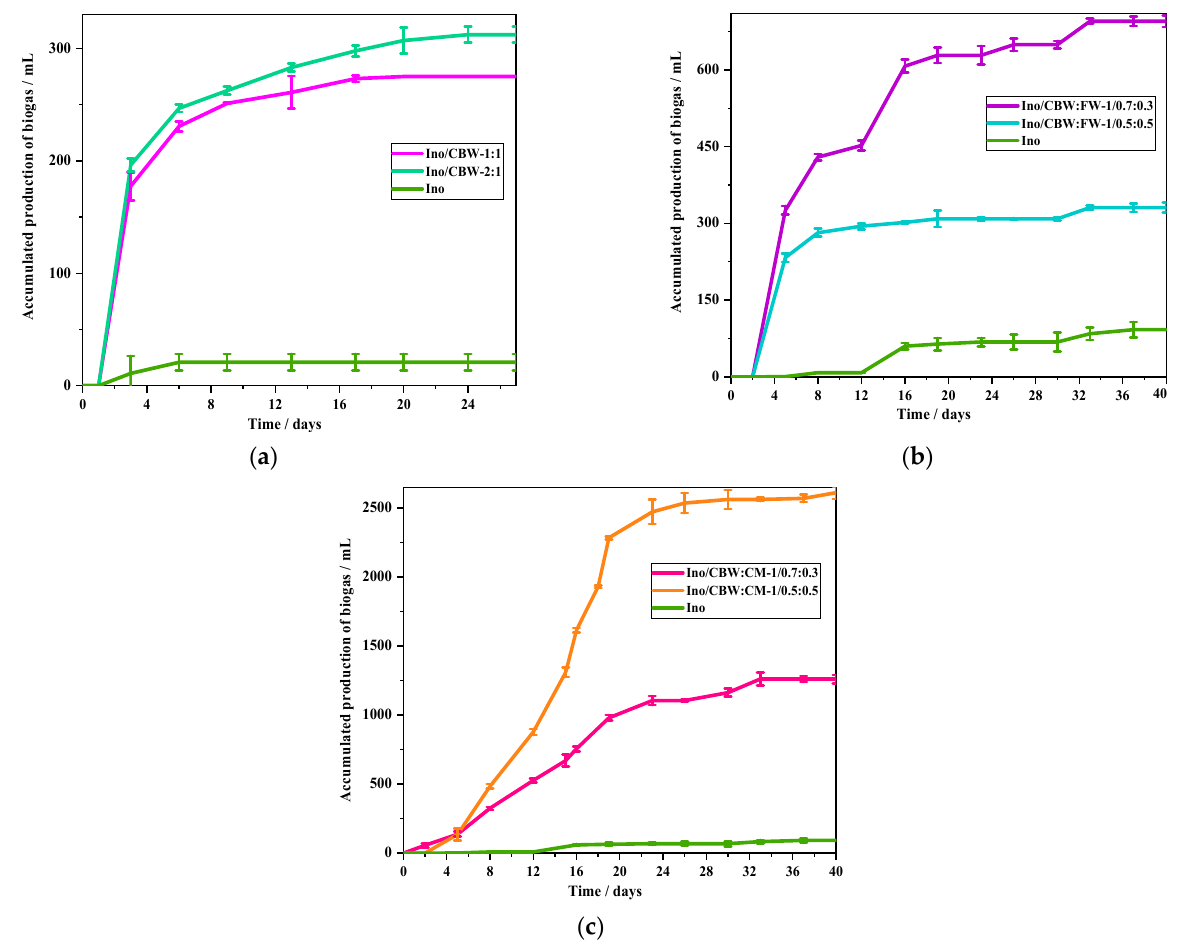
Figure 1. Accumulated biogas for the tests ( a ) anaerobic digestion (AD) of different ratios of mixture of inoculum and cork boiling wastewater (Ino/CBW); ( b ) anaerobic digestion of different ratios of mixture of inoculum, cork boiling wastewater, and food waste (Ino/CBW:FW); ( c ) anaerobic digestion of different ratios of mixture of inoculum, cork boiling wastewater, and cow manure (Ino/CBW:CM).